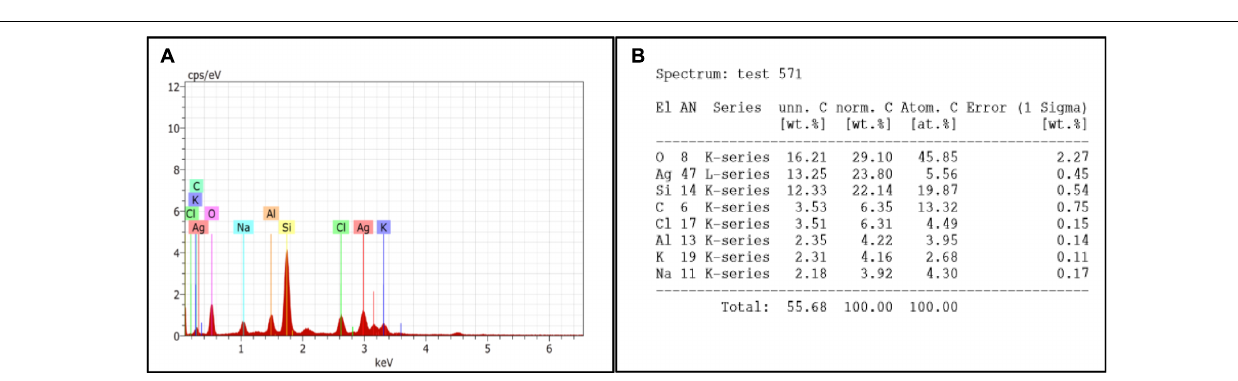
Frontiers in Microbiology |